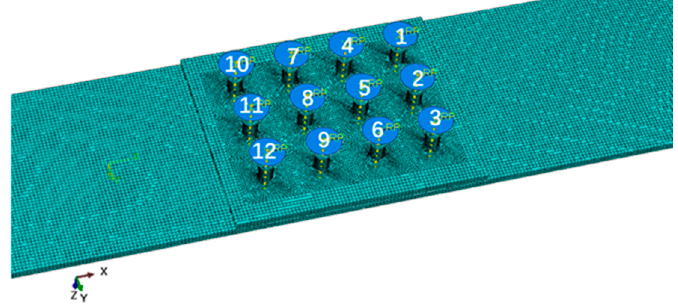
Figure 5. Schematic diagram for Meshing Model of riveted single-strap butt joints.